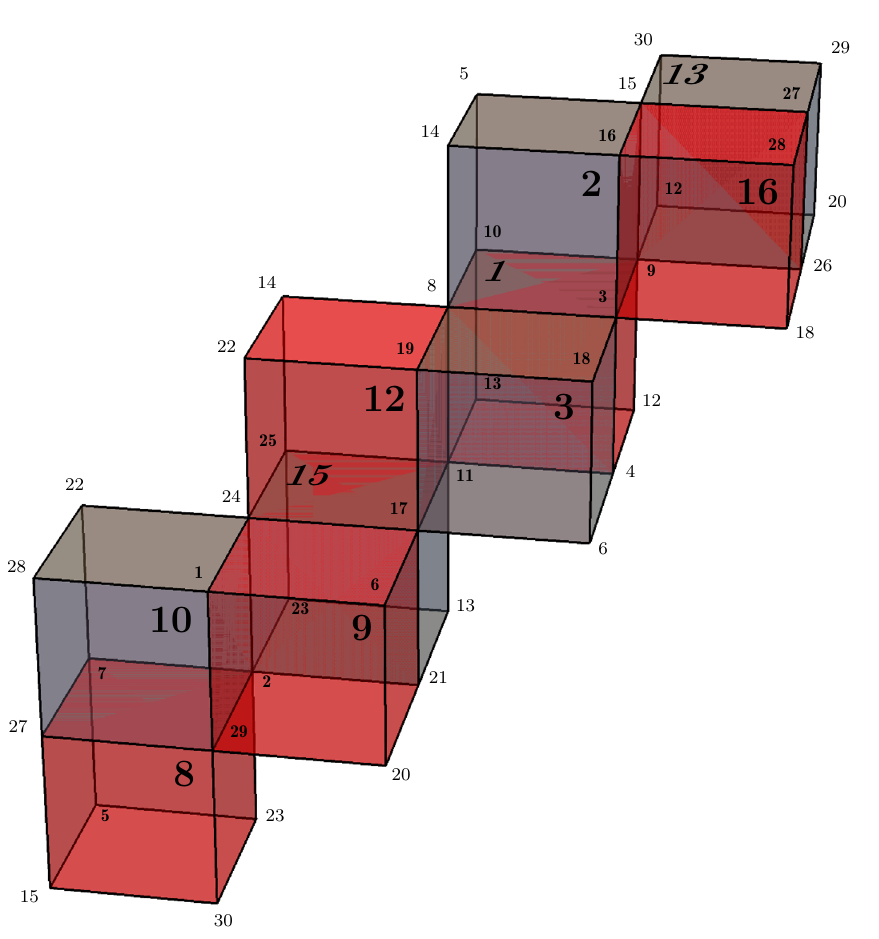
Figure 15 . The remaining dual facets form a second orbit of A 2 B , descending from v 13 , in this (cid:12)gure. The facet f f 15 ; f 30 ; f 29 ; f 27 g of v 8 is identi(cid:12)ed with the corresponding facet of v 13